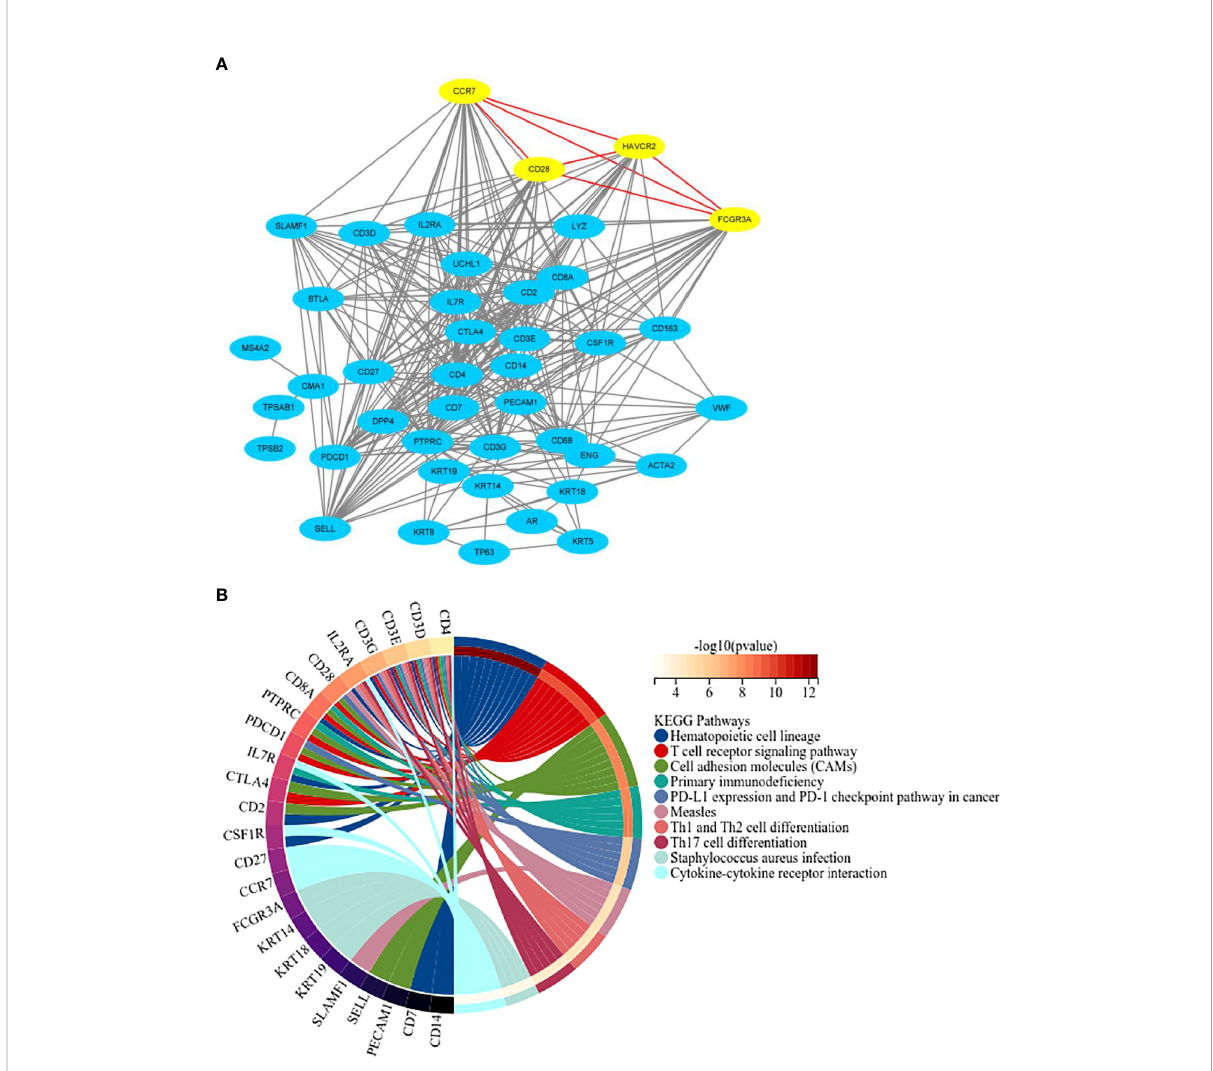
FIGURE 1 PPI network construction and KEGG pathway enrichment analysis. (A) Protein-protein interaction network for 42 candidate marker genes in String database. (B) The top 10 pathways of KEGG pathway enrichment